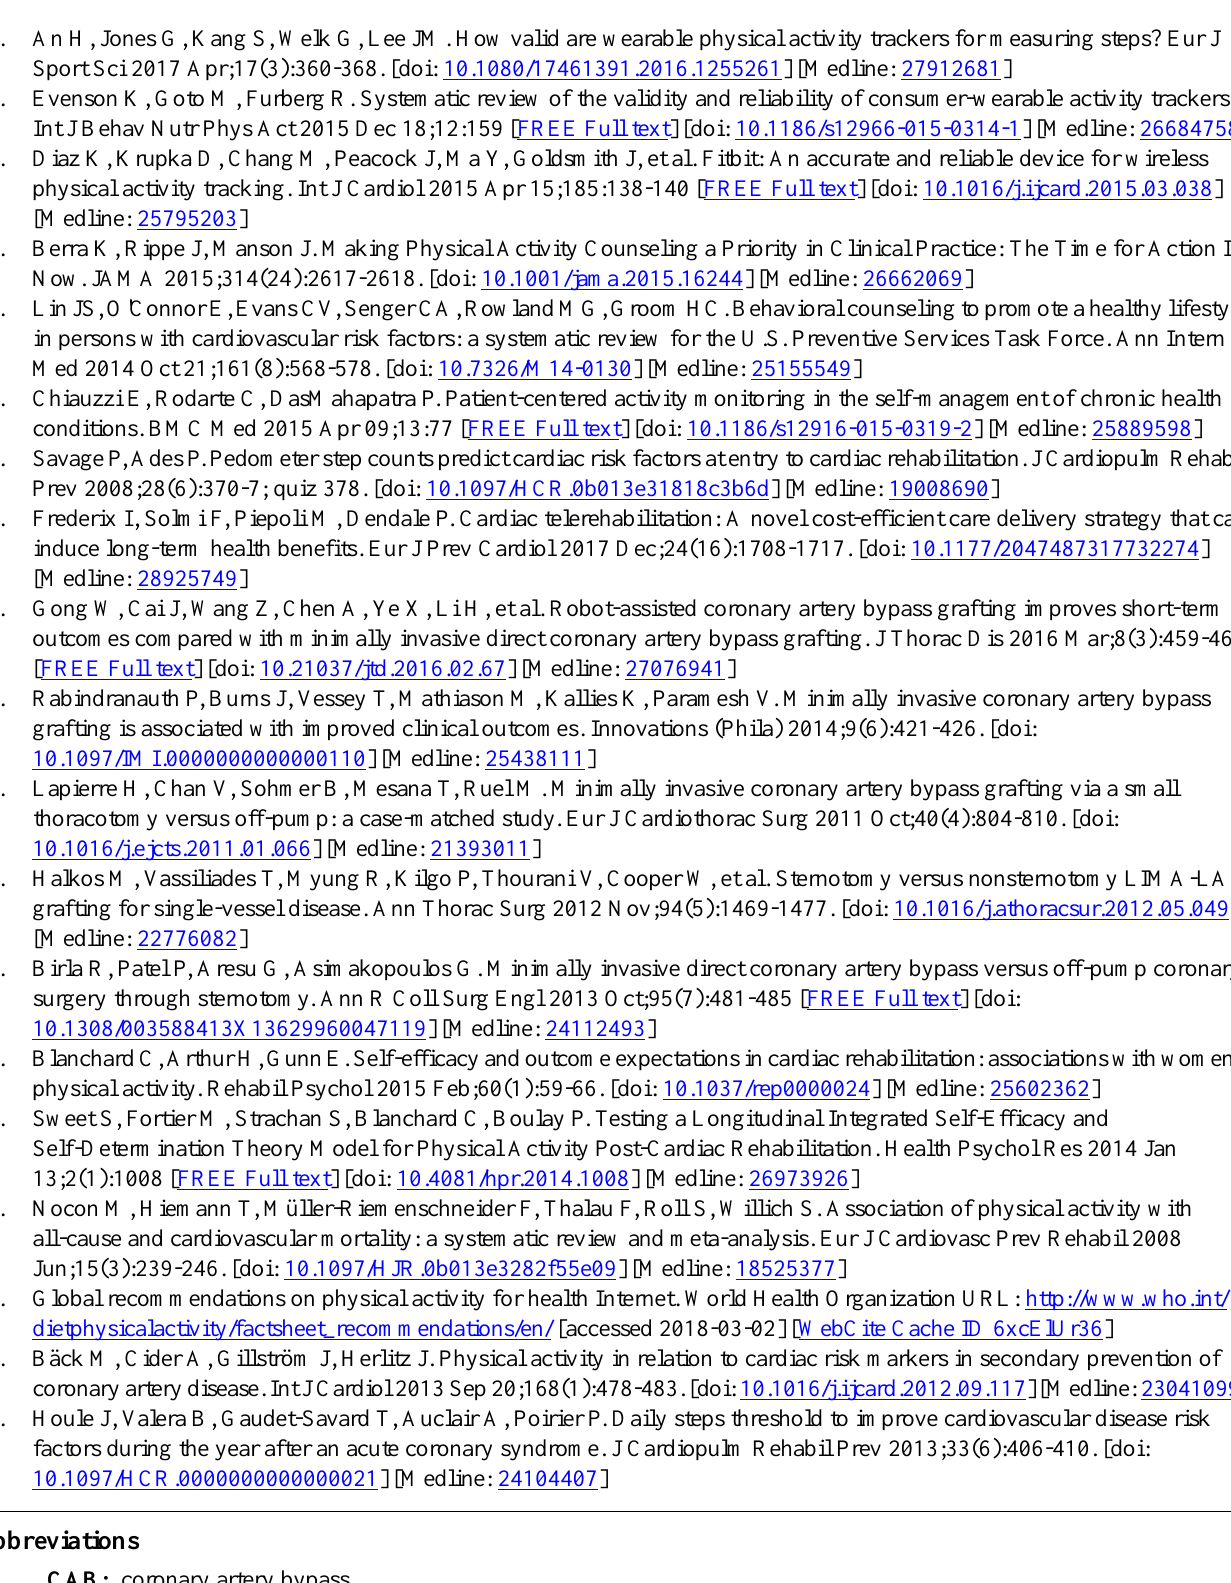
CABG: coronary artery bypass grafting EuroSCORE II: European System for Cardiac Operative Risk Evaluation NYHA: New York Heart Association functional classification of heart failure OPCAB: off-pump coronary artery bypass RA-MIDCAB: robotically assisted minimally invasive direct coronary artery bypass STEMI: ST-segment elevated myocardial